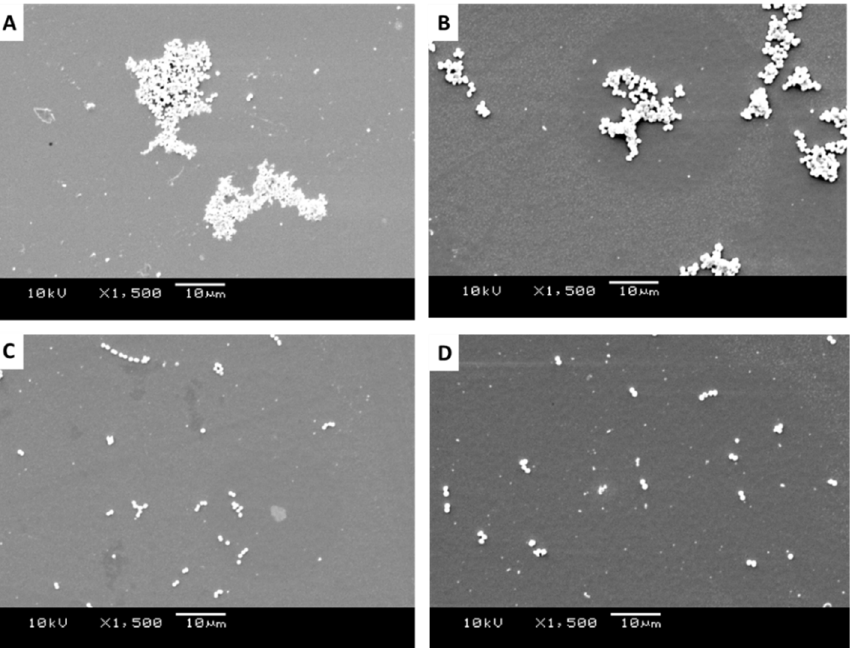
Figure 7. SEM images of retained bacteria on smooth titanium: ( A ) S. aureus , ( B ) M. luteus , ( C ) Strep. pyogenes , and ( D ) S. sciuri .